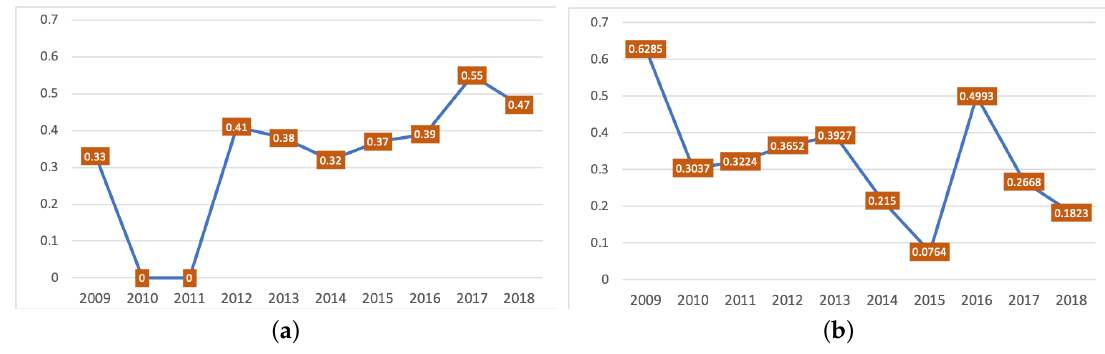
Figure 6. Rank order correlation between hashtags in the climate change and global warming discourses from 2009 to 2018 ( a ); correlation between matrices of the climate change discourse and the global warming discourse from 2009 to 2018 ( b ).